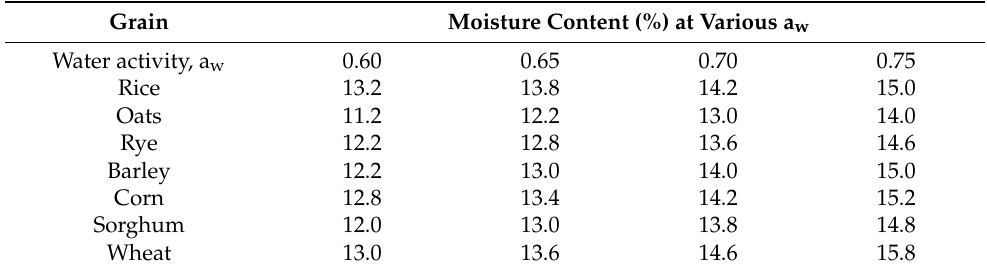
Table 1. Moisture content of several grains relative to water activity at 25 ◦ C (adapted from [55]). Grain Moisture Content (%) at Various a w Water activity, a w